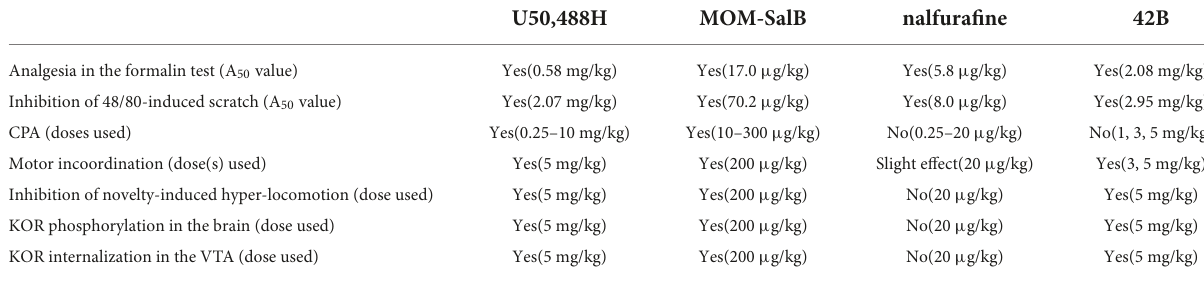
TABLE 1 Summary of effects of the four KOR agonists on behaviors and KOR phosphorylation in male CD-1 mice and KOR internalization in male KOR-tdT